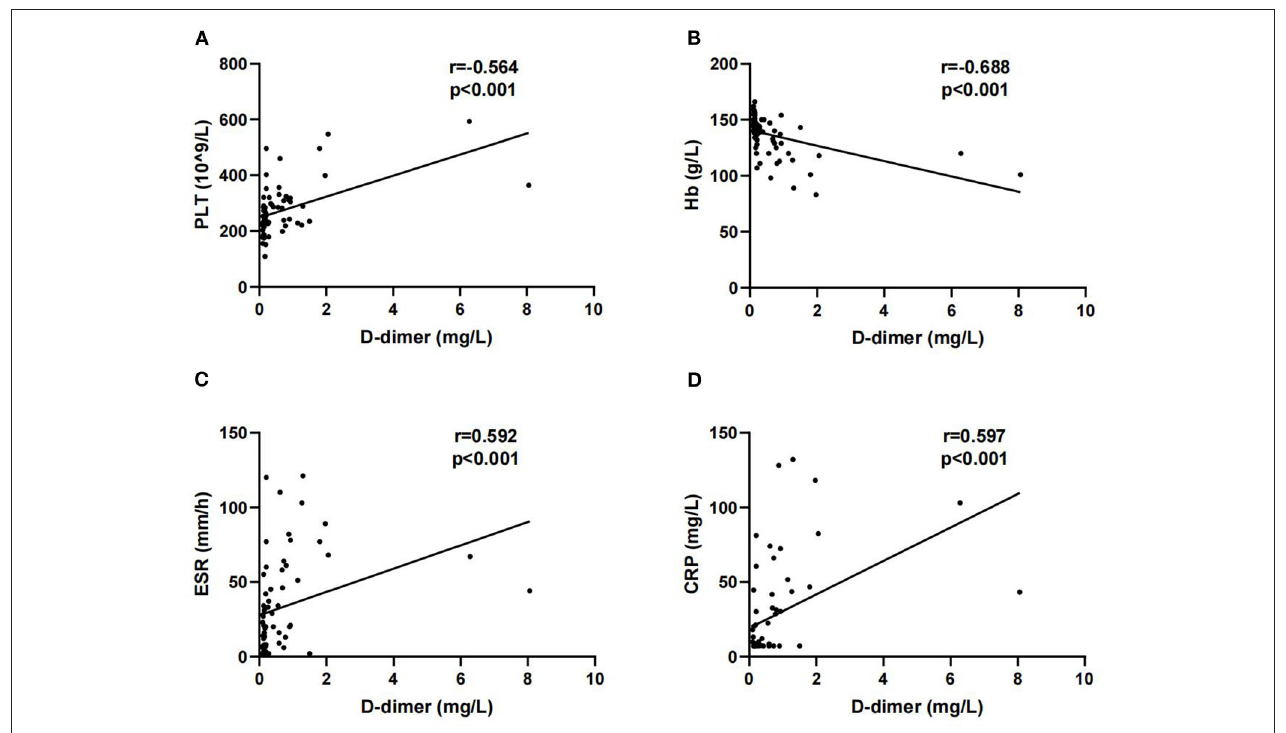
FIGURE 1 | Correlations of D-dimer with platelet (PLT) (A) , Hb (B) , erythrocyte sedimentation rate (ESR) (C) and C-reactive protein (CRP) (D)